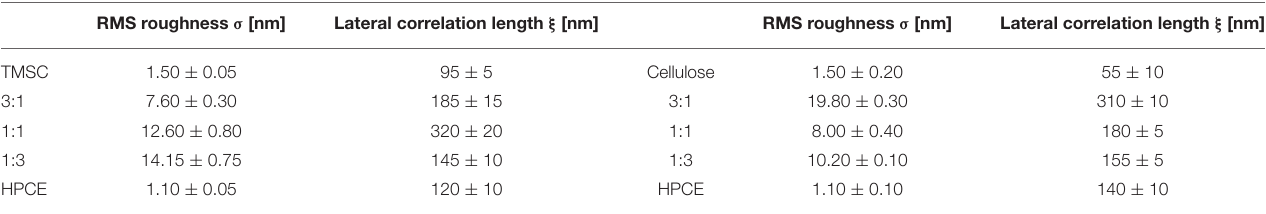
The data is obtained from analysis of the 5 µ m × 5 µ m topography images.